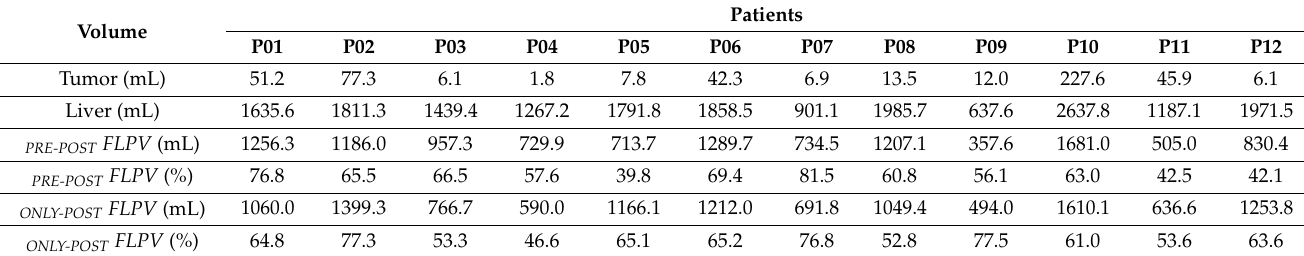
Table 2. Tumor and healthy liver volumes and identified FLPVs in both PRE-POST R2* and ONLY-POST R2* approaches across 12 liver cancer patients. The percentage (%) of PRE-POST FLPV and ONLY-POST FLPV was calculated using PRE-POST FLPV (%) = ( PRE-POST FLPV (mL)/liver volume (mL) × 100) and × ONLY-POST FLPV (%) = ( ONLY-POST FLPV (mL)/liver volume (mL)